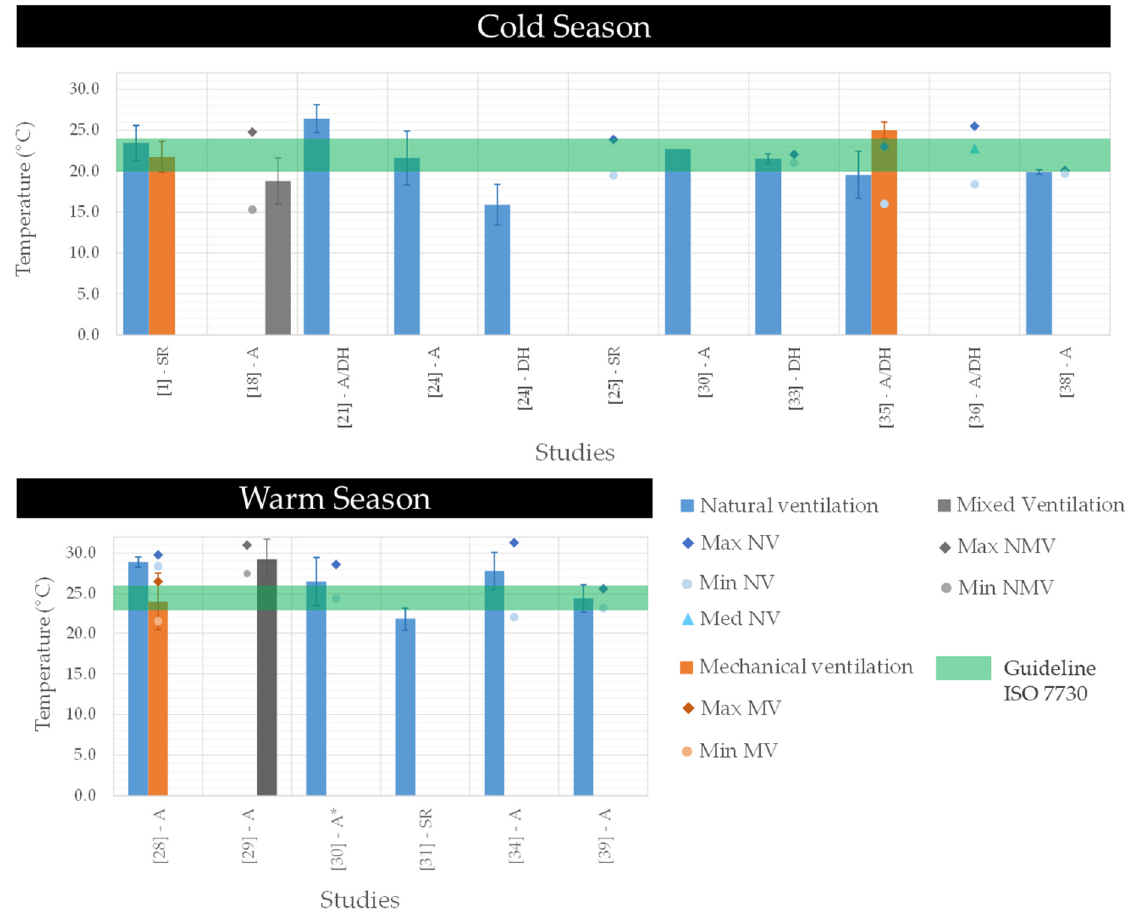
Figure 2. Temperatures monitored in bedrooms during warm and cold seasons, with natural (NV), mechanical (MV) and mixed (NMV) ventilation settings. Studies index is regarding type of building: A—apartment; A/DH—mixed (apartment and detached house); DH—detached house; SR—scholar residence. Bars provide mean values (along with standard deviation when available). Max, min and med stand for maximum, minimum and median values, respectively. *—This study does not specify the type of bedroom ventilation.